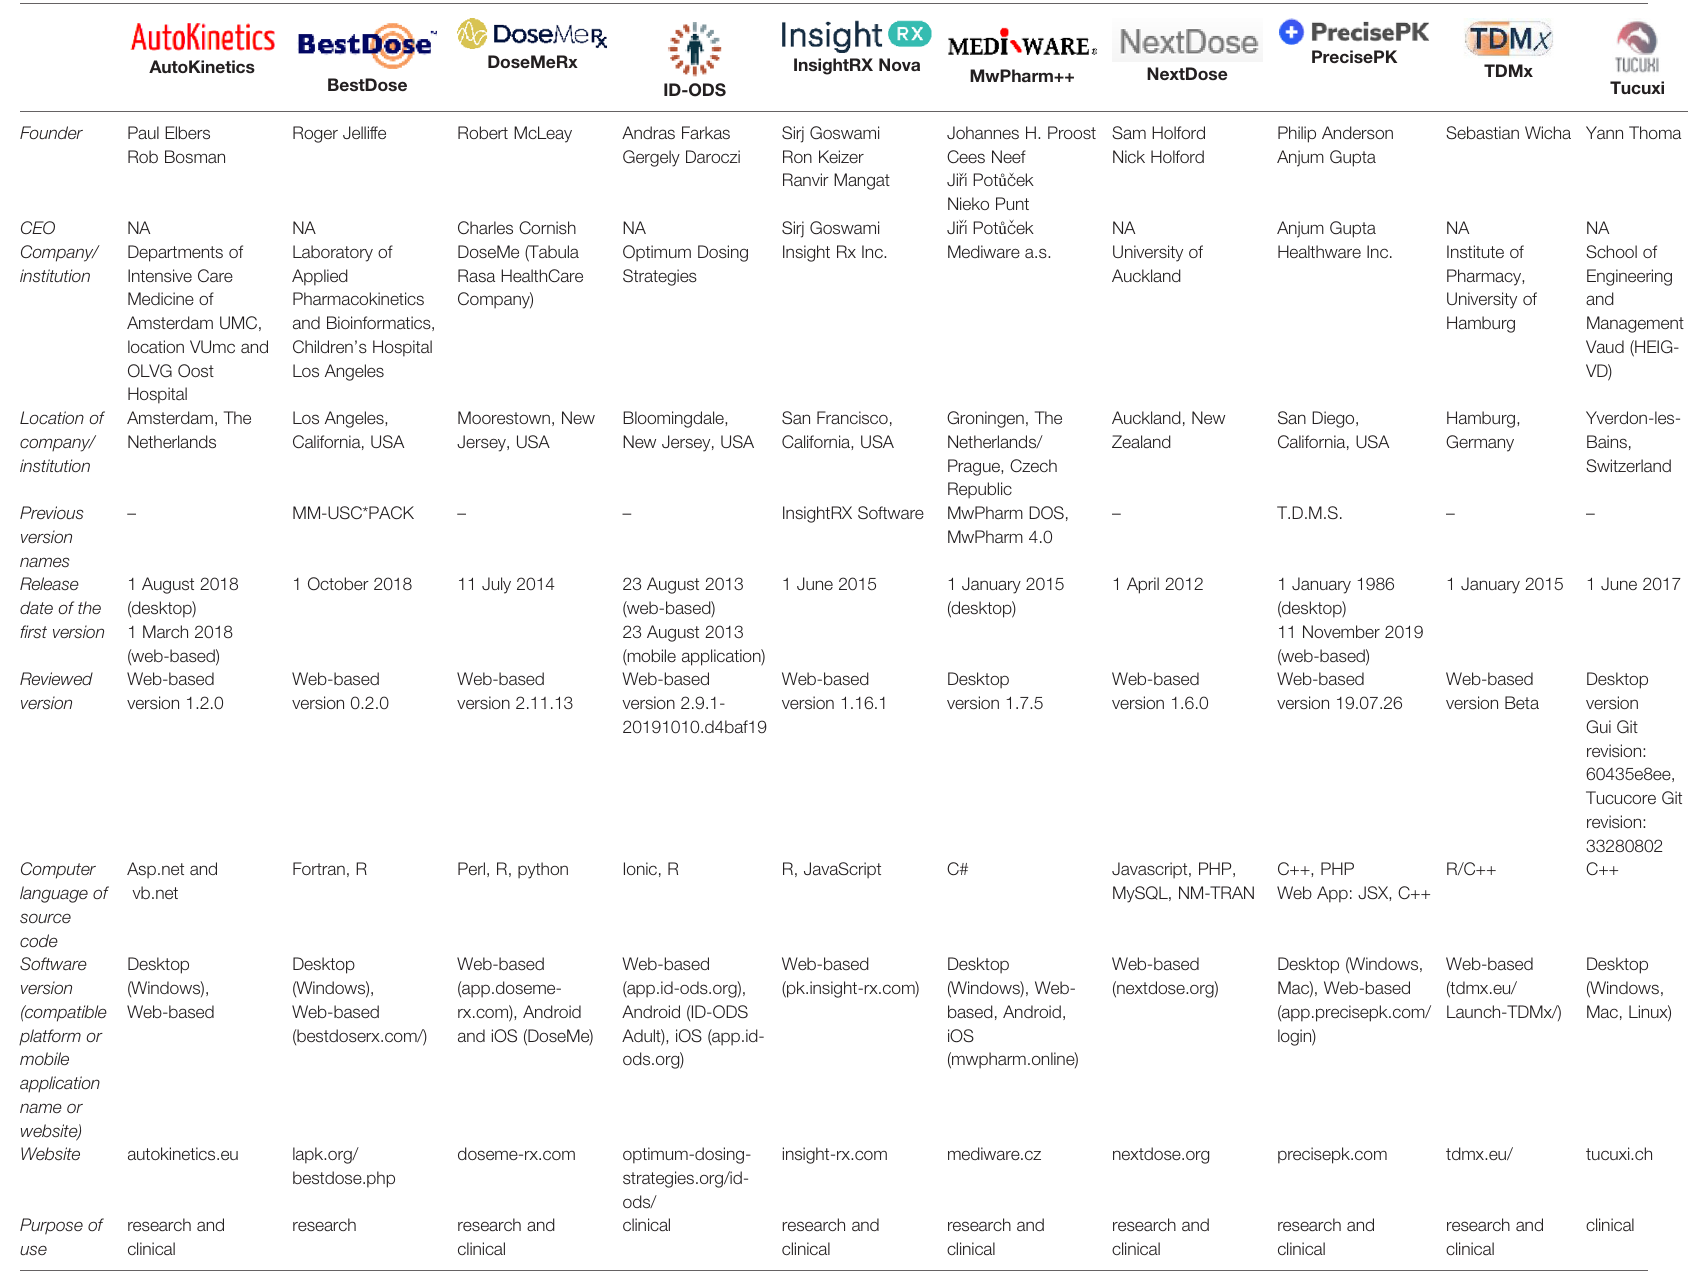
TABLE 1 | Descriptive characteristics of the model-informed precision dosing software